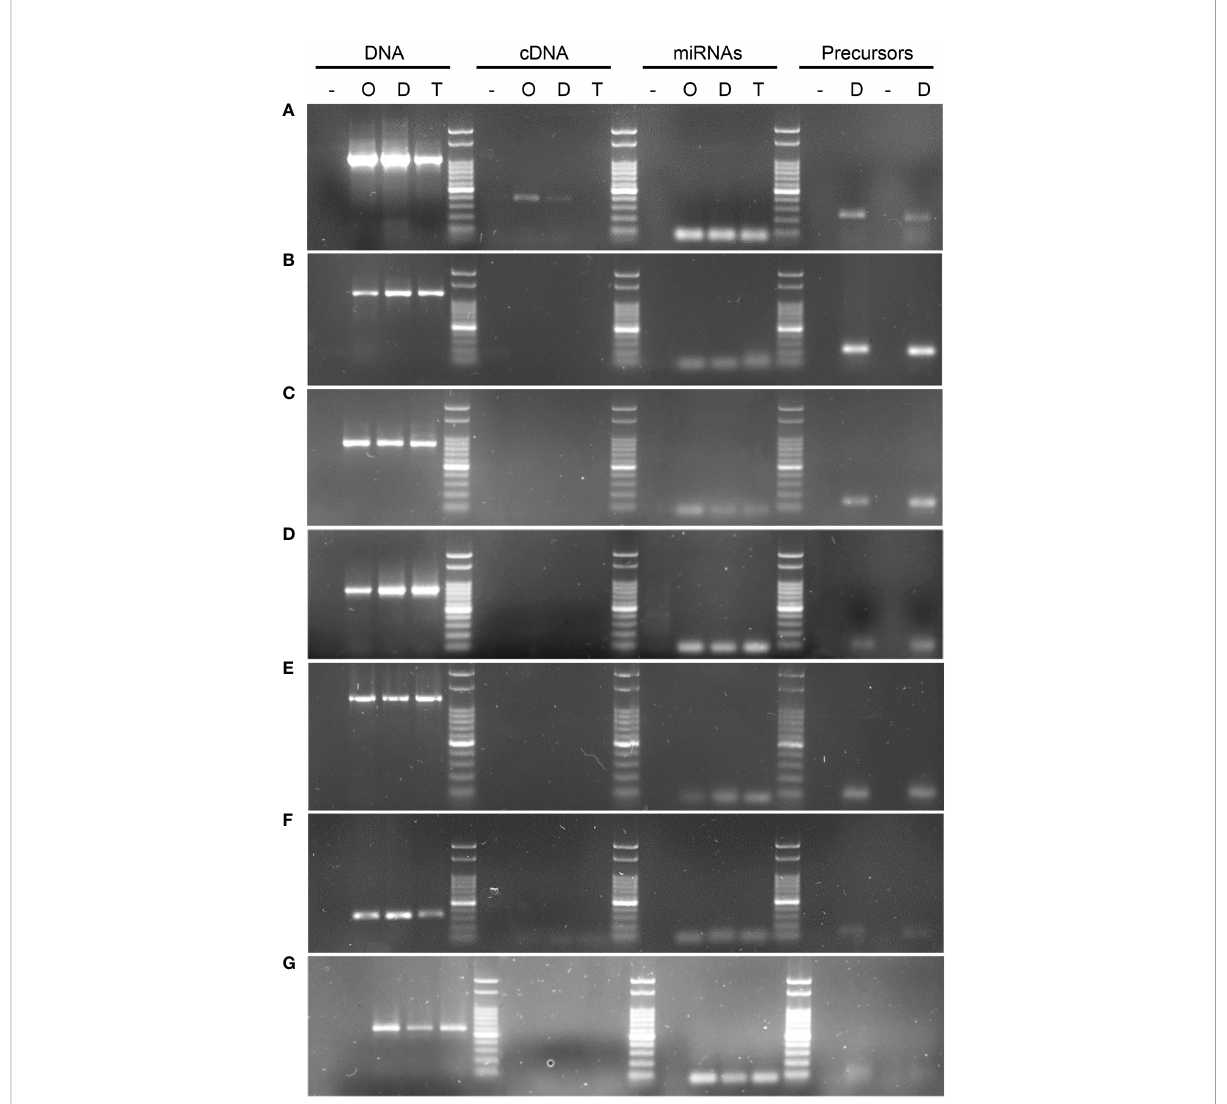
FIGURE 3 PCR and RT-PCR ampli fi cations using gene, transcript, miRNA, pri-miRNA and pre-miRNA based primers. The image shows DNA from the target genes could be ampli fi ed in all of the tested samples, whereas when cDNA was the template, this led to ampli fi cation bands for 1 of the 7 transcripts tested using several primers combinations (Table 5). (A) KINESIN, which showed ampli fi cation in cDNA, and was absent only in Tanganyika, (B) PATATIN, (C) GRF8, (D) DREB2, (E) DdRNAPolII1B, (F) GAMYB, (G) SQUAMOSA. UBICE gene was used for normalization of cDNA expression. The ampli fi cation using miRNA, pri-miRNA and pre-miRNA based primers allowed the validation of the novel and reported miRNAs tested in this